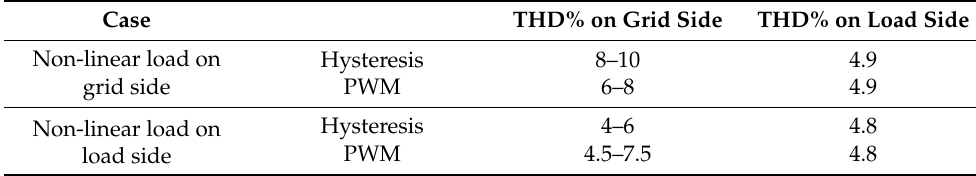
Table 2. Results compression for voltage